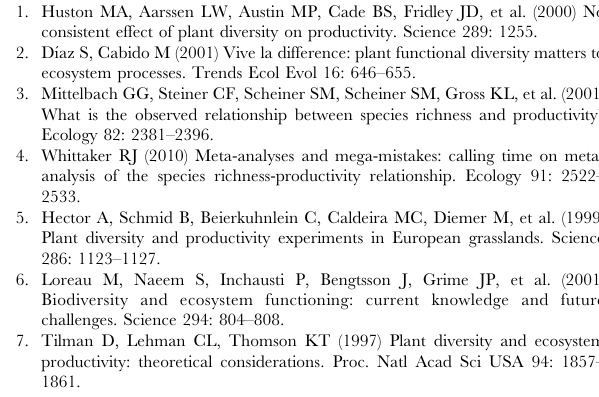
Table S1 Data of experiment I. The variables are self- evident. Table S2 Data of experiment II. The variables are self- evident.